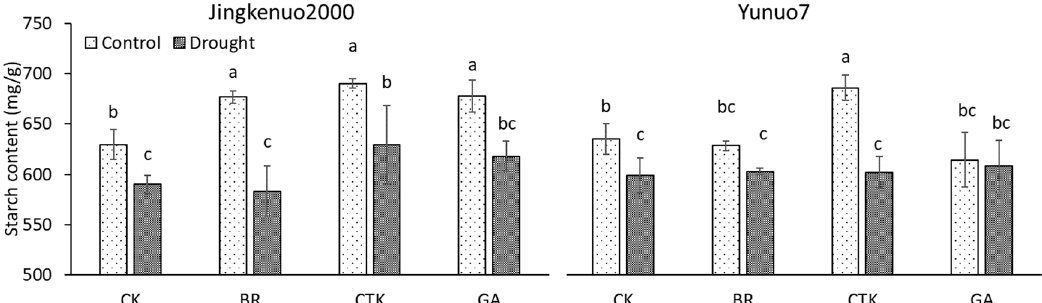
Figure 2. The grain starch content with exogenous hormones under control and drought conditions in waxy maize. CK, water; CTK, cytokinin; BR, brassinolide; GA, gibberellic acid. Bars mean SE (n = 3). Different letters above the bars in each hybrid are significantly different at 5% probability level.